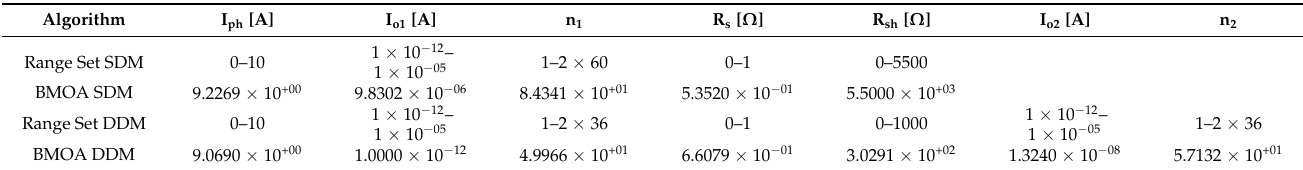
Table 15. Sharp ND-R250A5 photovoltaic panel parameters and